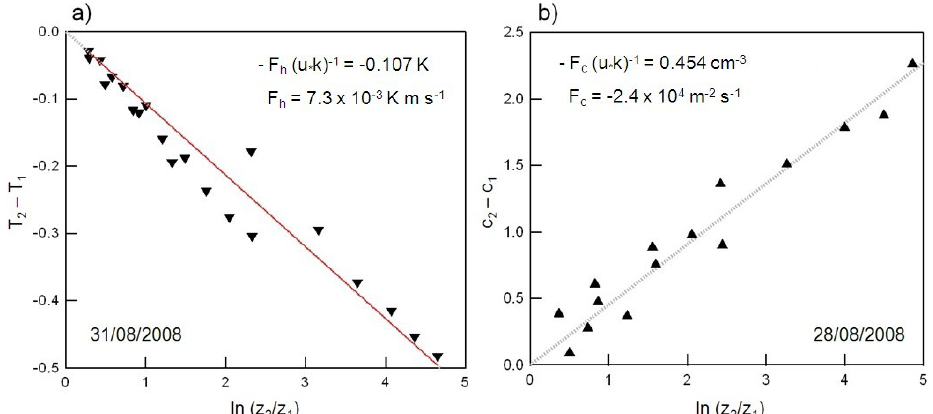
Fig. 7. Estimation of (a) the sensible heat flux F h on 31 August and (b) the particle number flux F c on 28 August from a linear regression of the temperature and particle concentration profiles according to Eqs. (6) and (7),